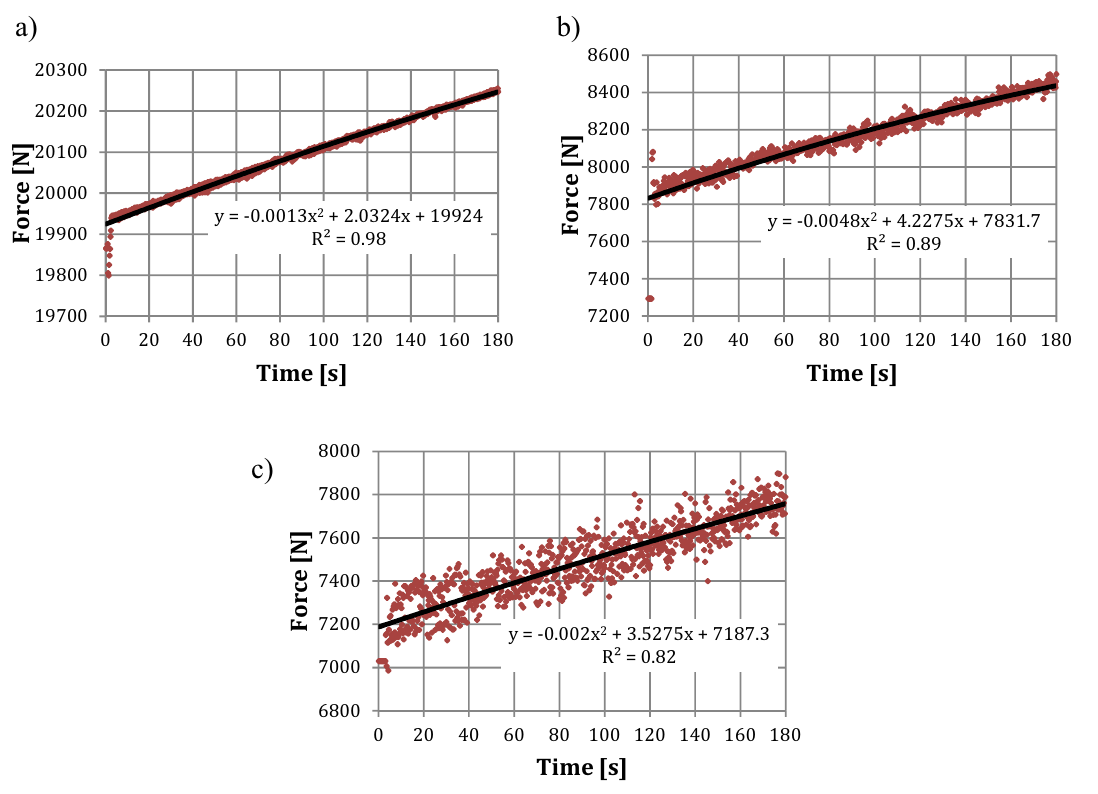
Figure 15. The force changes generated by the water stream for a given distance from the outlet of the nozzle depending on the time: ( a ) at the outlet of the nozzle; ( b ) for a distance of 0.05 m from the inlet of the nozzle; ( c ) for a distance of 0.10 m from the inlet of the nozzle.